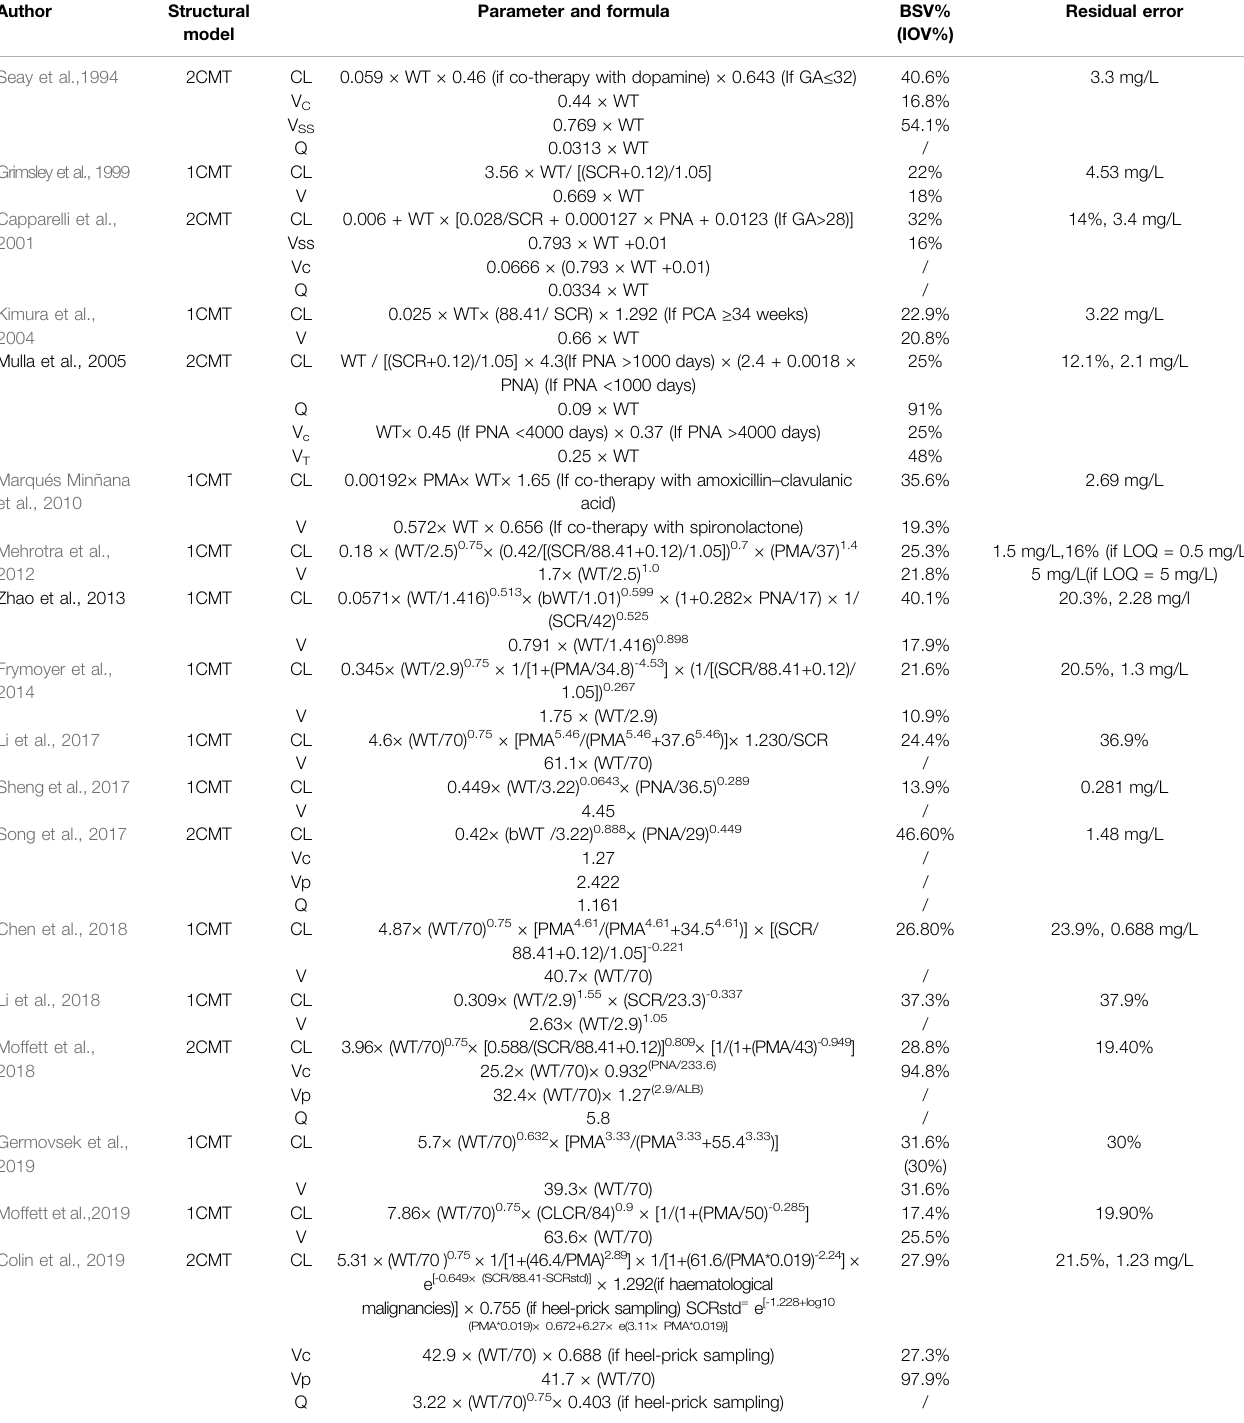
TABLE 2 | Summary models ’ information of published population pharmacokinetic studies of vancomycin in neonates.